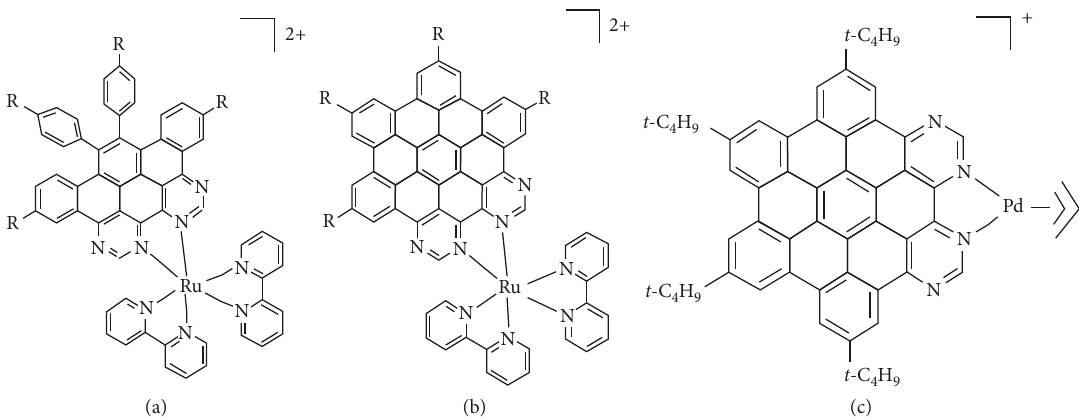
Figure 5: (a, b) Ruthenium and (c) palladium-graphene complex [64].